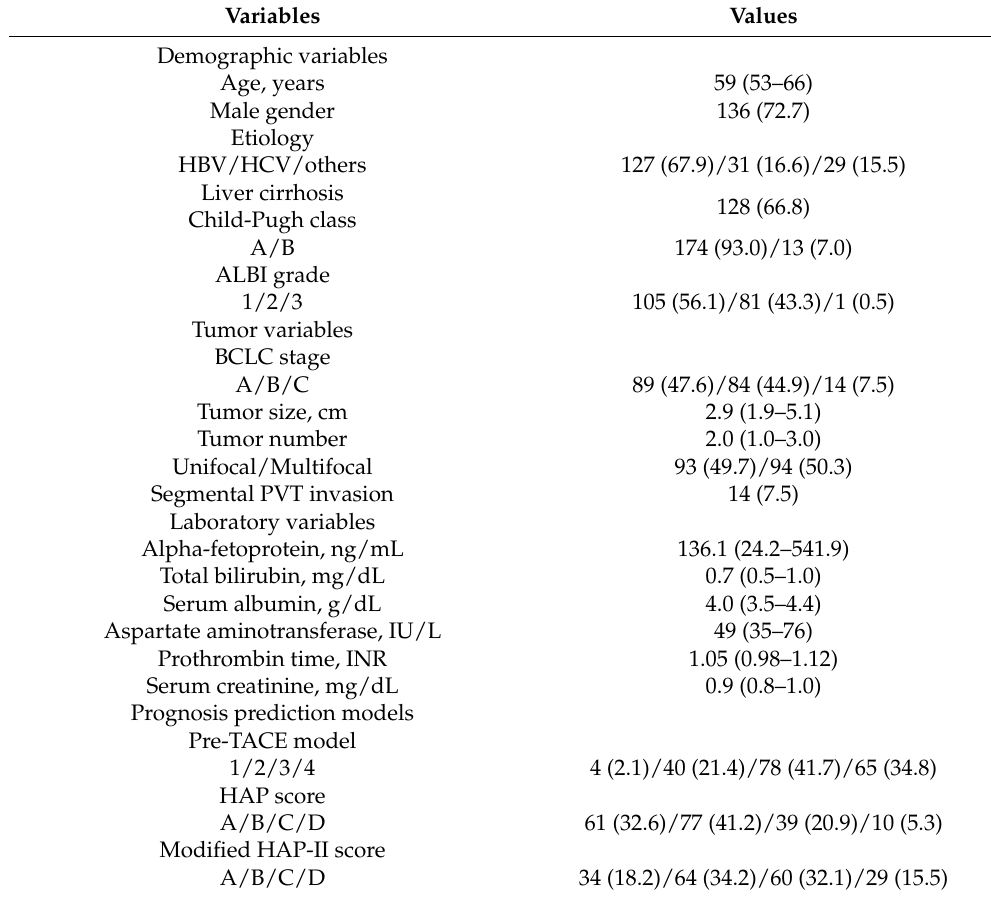
Table 2. Baseline characteristics of the study population ( n =